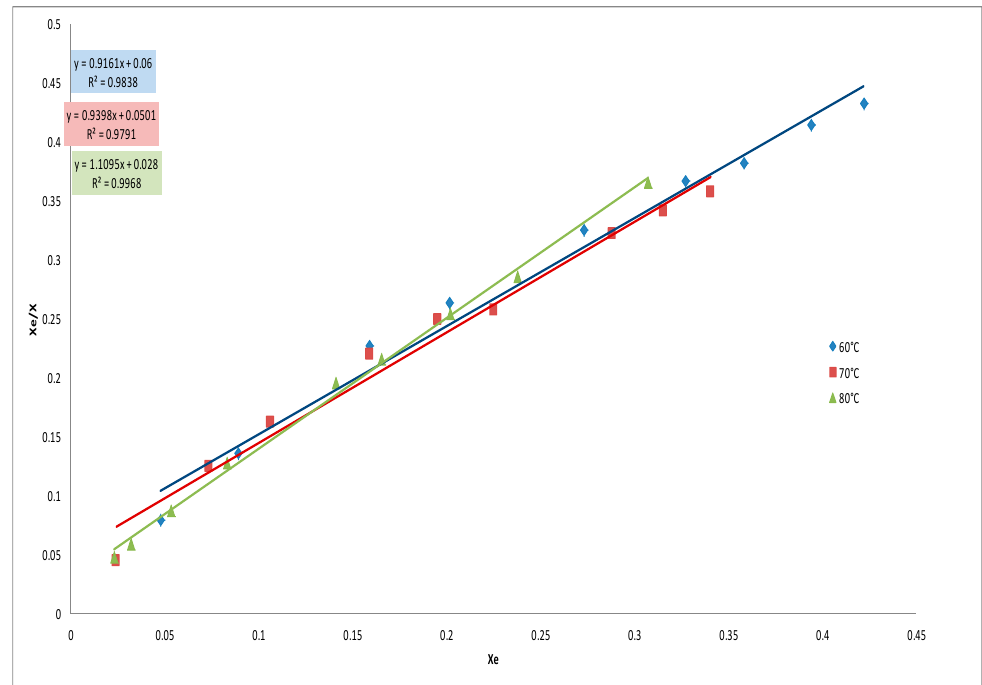
Figure 5. Modeling of the adsorption isotherms for the decolorization process with AC from neem using the Langmuir isotherm.